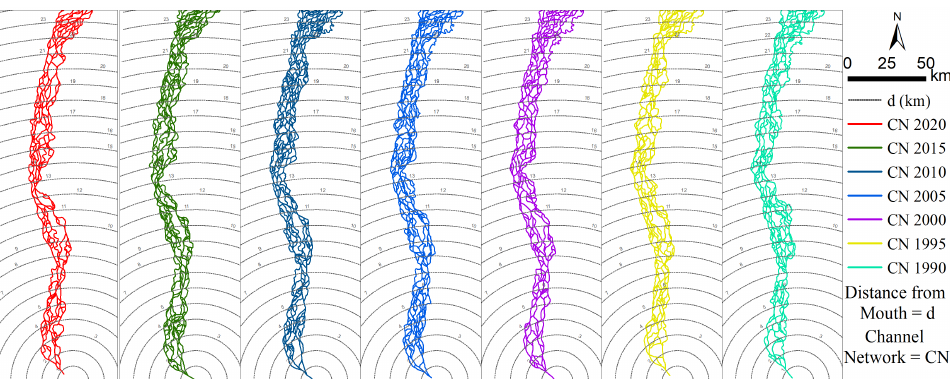
Figure 3. Delineation of the channel network for seven selected years from 1987 to 2020, based on the dry season of the Brahmaputra